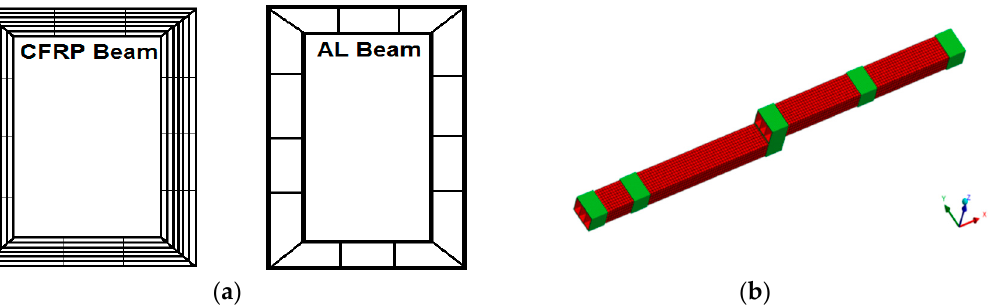
Figure 8 . Mesh details for top link models created from AA and CFRP materials: ( a ) cross ‐ sections of CFRP and AA beams, and ( b ) schematic of the 5 ‐ DOF robot manipulator’s top link .